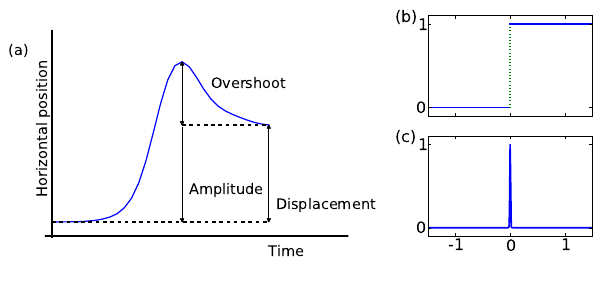
Figure 1 . Microsaccades can mathematically be defined as superposition of two functions with singular points. (a) We have labeled several attributes which allow a further descrip- tion of the eye’s displacement. The eye’s trajectory is drawn on the Y-axis against time on the X-axis. Smoothing the (a) Heavyside and (b) Dirac delta function and superpose them, will return a microsaccade shape.